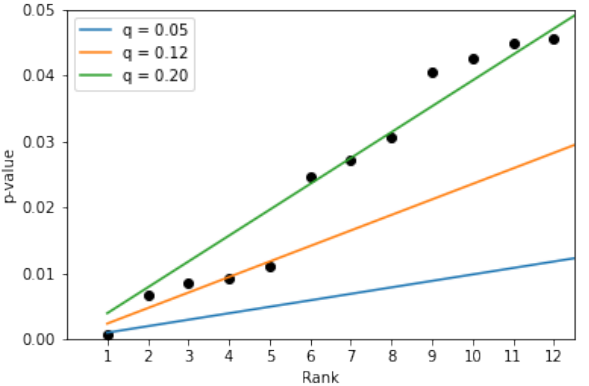
Figure 7. Top 12 p -values obtained after applying paired t -test for positive/negative opinions on the basis of all samples and the cutoff lines set according to the Benjamini–Hochberg